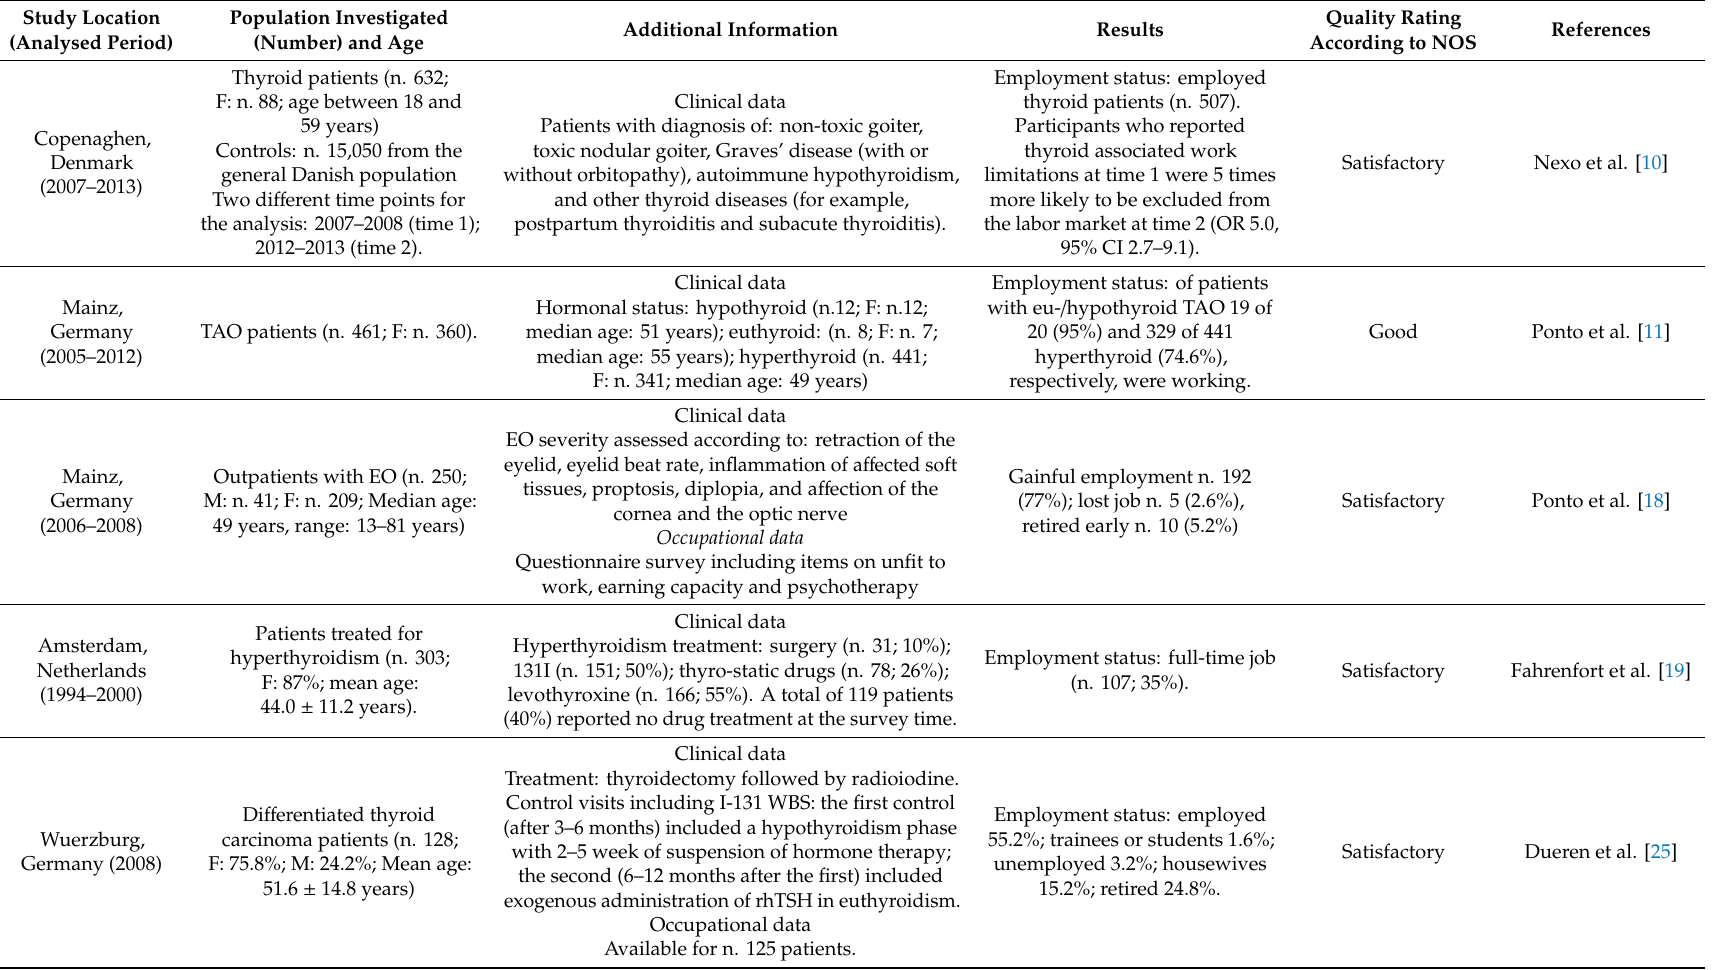
Table 1. Studies addressing the impact of thyroid disease on employment